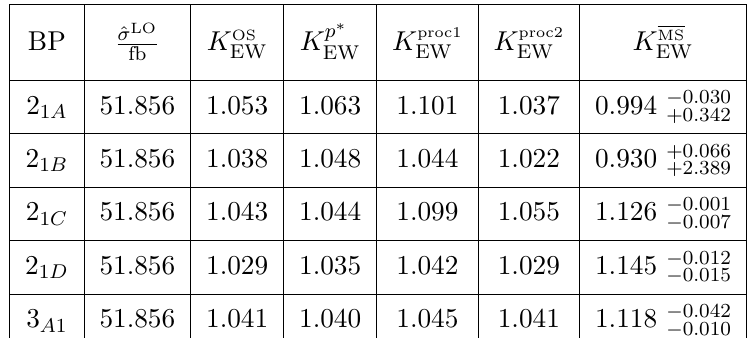
Table 3 . The NLO electroweak K-factors for the process g + g points (BP) in the alignment limit are shown. They are de(cid:12)ned in table 1. The renormalization scale has been set to (cid:22) 0 as de(cid:12)ned in eq. (3.4) for the MS scheme. The lower (upper) value of